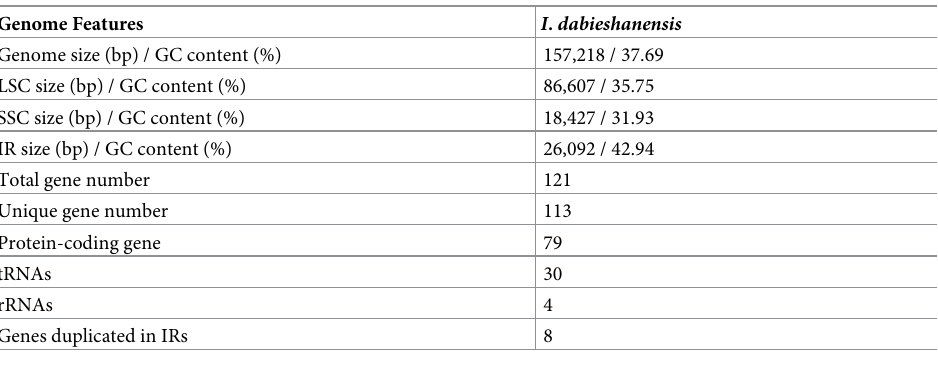
LSC, large single copy region; SSC, small single copy region; IR, inverted repeat.